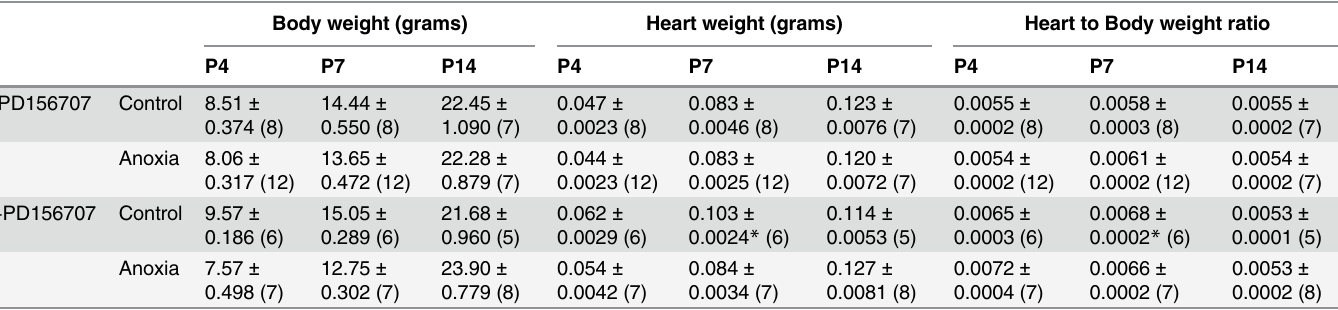
Body and isolated hearts were weighed from day 4, 7, and 14 neonatal rats that were treated with control or anoxia, in the absence or presence of PD156707. Heart to body weight ratio values are also represented. Data are means ± SEM. * P < 0.05, control-PD156707 vs . +PD156707. Number of animals is represented in